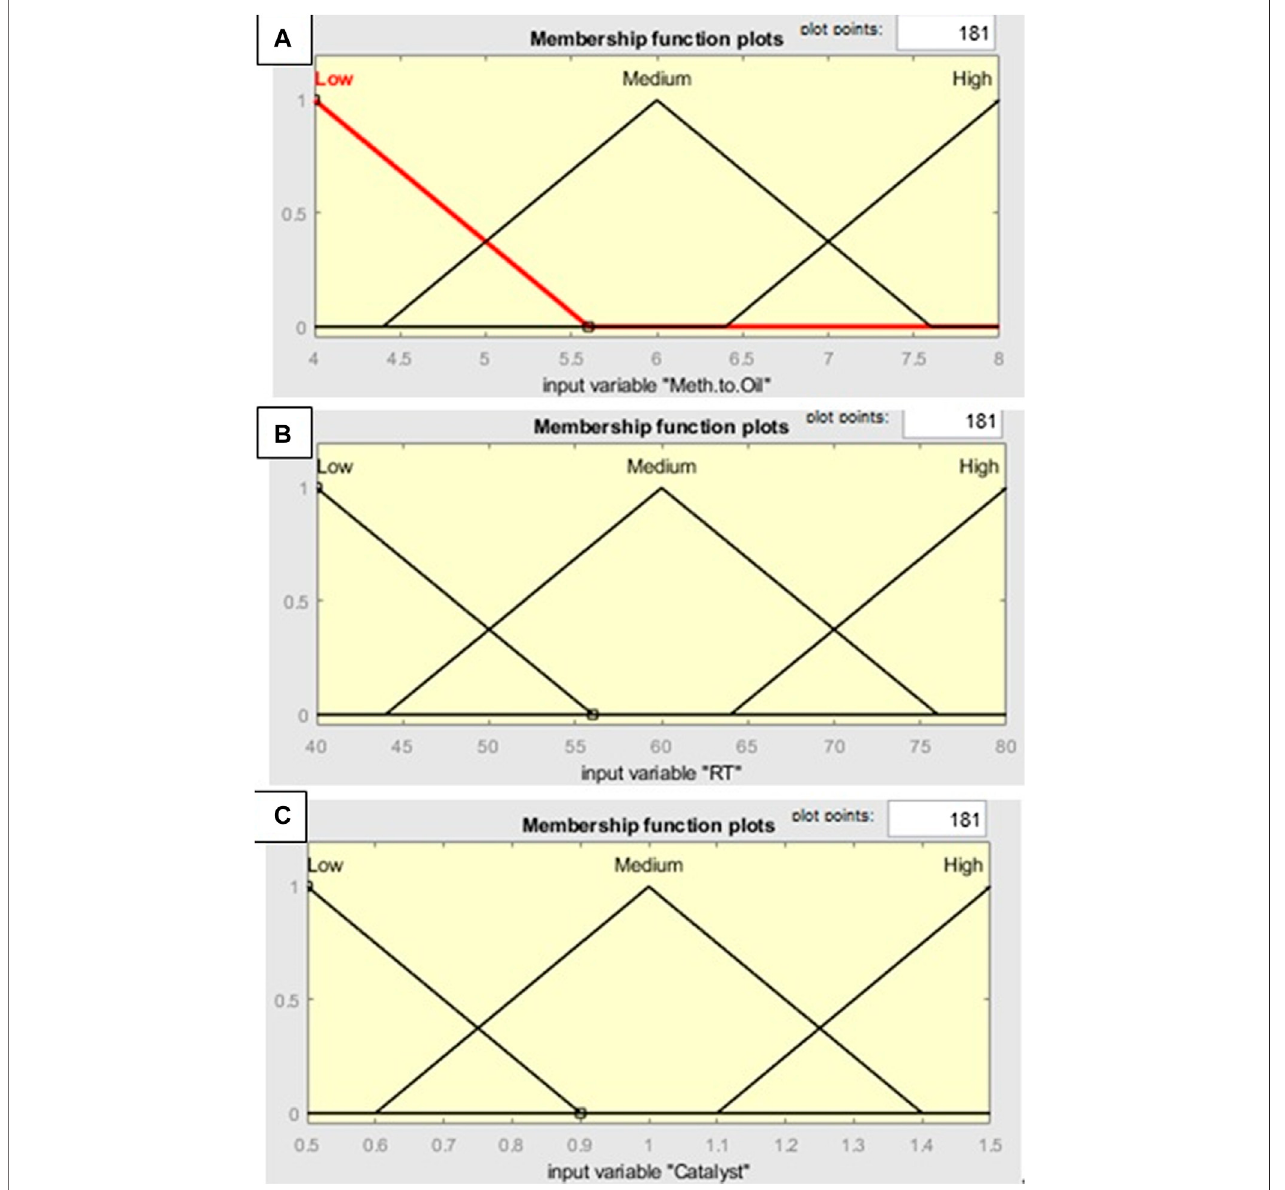
TABLE 2 | Parameters for membership for input and output for TSOME. Membership